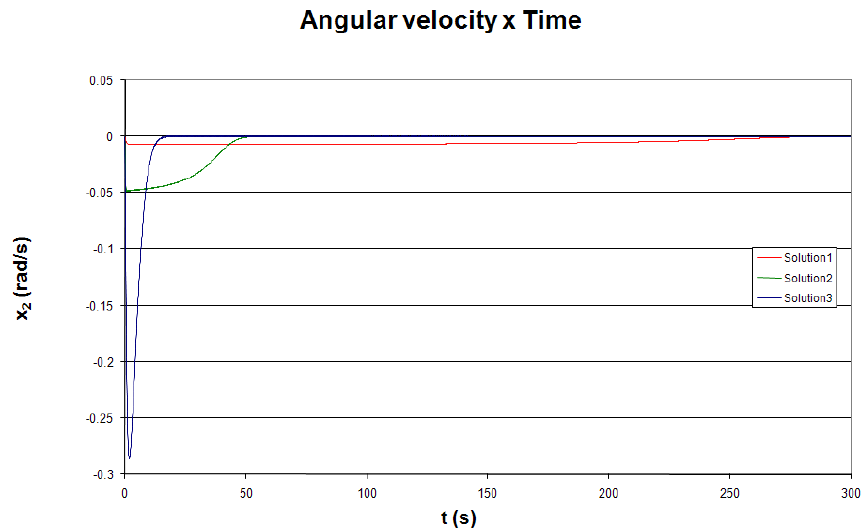
Fig. 5. Angular displacement for the three solutions 1, 2 and 3.